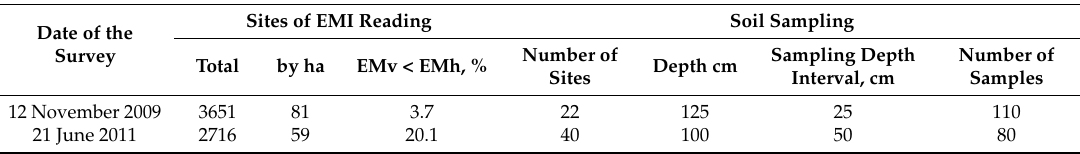
Table 1. Total number of sites of EMI readings, sites by ha, and % inverted profiles (EMv < EMh); number of soil sampling sites, depth, sampling depth interval, and number of